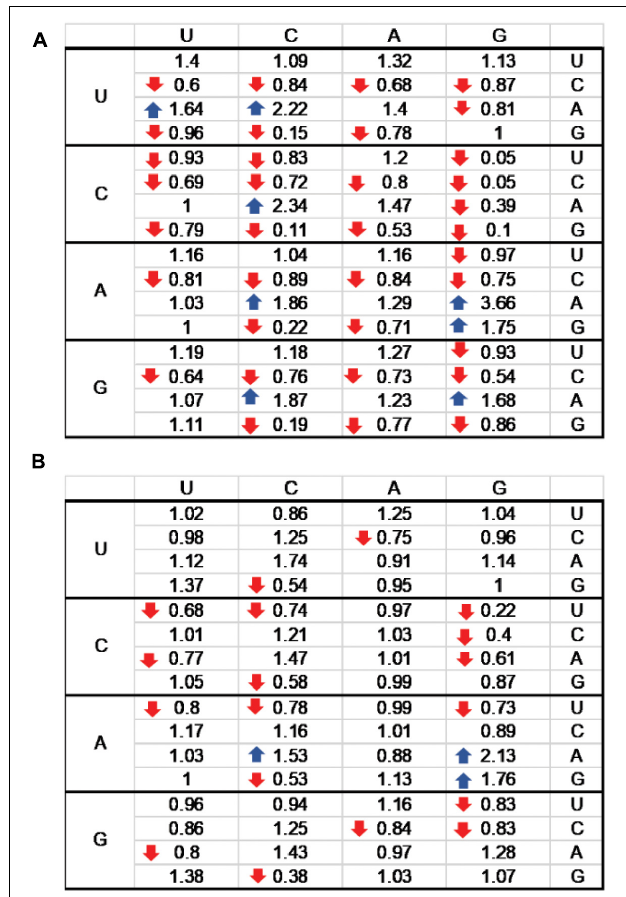
FIGURE 5 | Relative synonymous codon usage (RSCU) index for RSV (A) and MeV (B) genomes. The standard genetic code table with RSCUs for RSV (A) and MeV (B) is shown. RSCU indices < 1.0 are indicated by downward arrow icons; RSCU indices > 1.5 are indicated by upward arrows. U, C, A, and G indicate uracil, cytosine, adenosine, and guanosine,